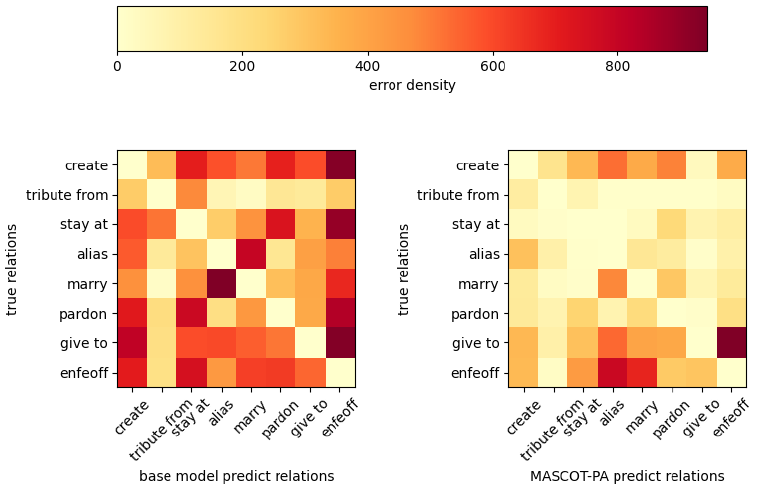
Figure 7. Wrong predicted relation distributions for base model and